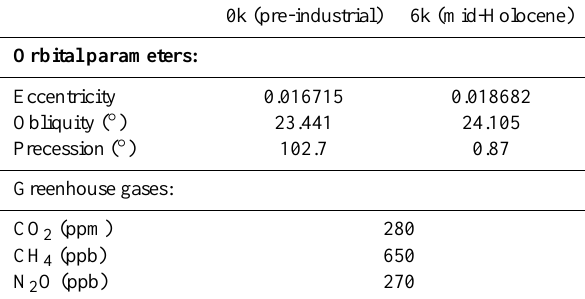
Table 3. Orbital parameters derived from Berger (1978) and green- house gas concentrations following the PMIP protocol for 6 k (Har- rison et al.,